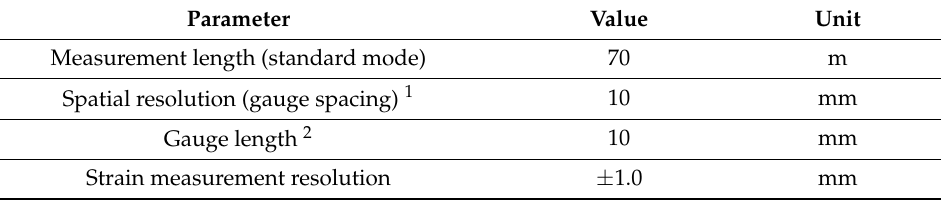
Table 2. Selected parameters of applied optical backscatter reflectometer. Parameter Value Unit